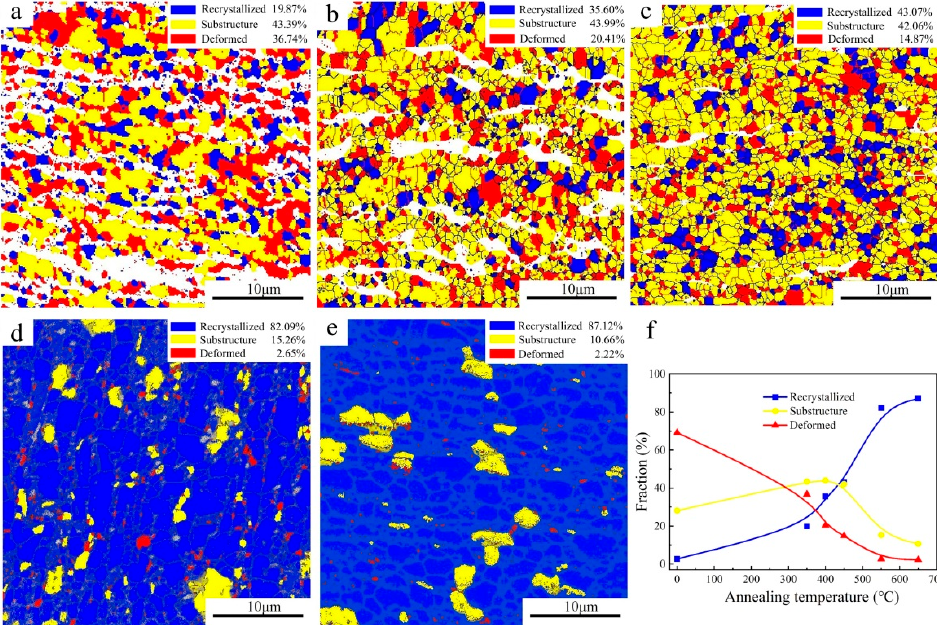
Figure 7. Recrystallization maps of the UFG TiFeB alloy after annealing for 1 h at different annealing temperatures of ( a ) 350 °C, ( b ) 400 °C, ( c ) 450 °C, ( d ) 550 °C, and ( e ) 650 °C. ( f ) The variation curve of the volume fraction with annealing temperature.